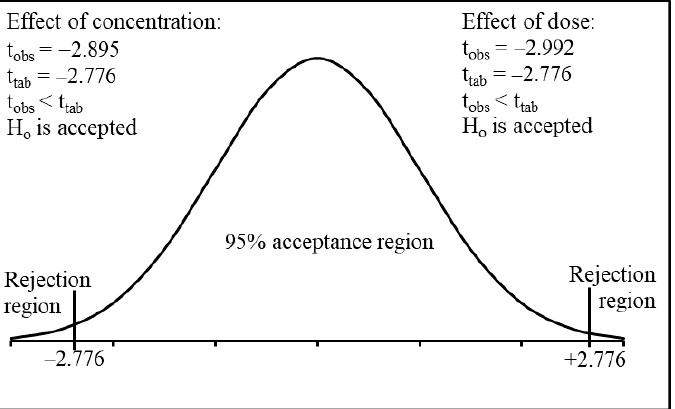
Figure 2. Probability chart for t distribution of 2-tailed test for the effect of dose and different fluoride concentrations.